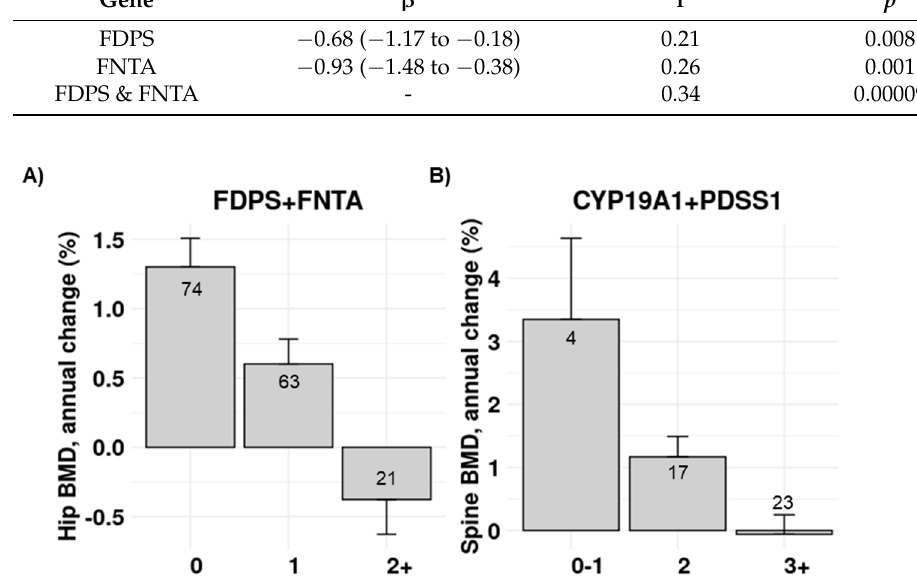
Figure 7. Bar plots showing the average (mean and SEM) changes in BMD across different genotypes combining alleles of two genes: ( A ) annual change in hip BMD after BP therapy across combined FDPS and FNTA genotypes; ( B ) annual change in spine BMD after SERM therapy across combined CYP19A1 and PDSS1 genotypes. Genotypes are divided into groups ( X -axis) according to the number of risk alleles (that is, alleles associated with smaller drug response). The numbers in the bars represent the number of women in each group.